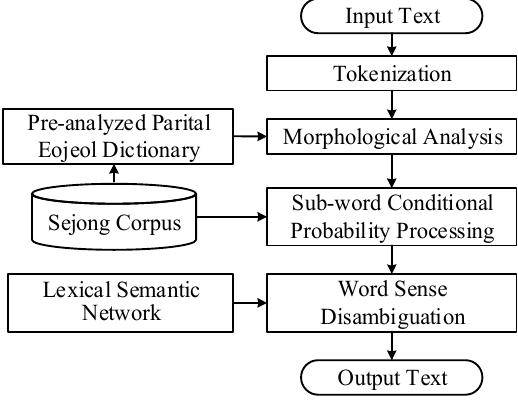
Figure 4. The architecture of the morphological analysis and word-sense annotation system.